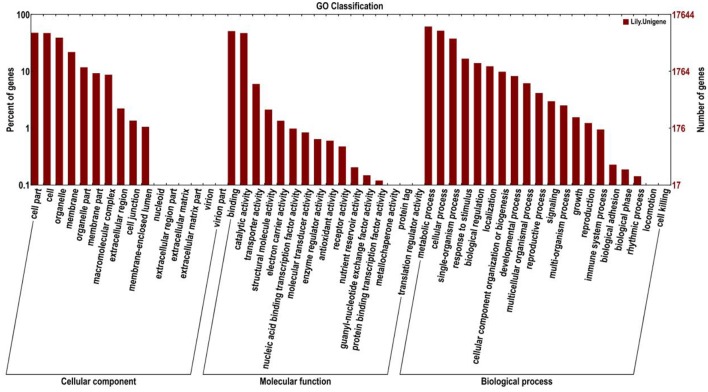
Histogram presentation of Gene Ontology (GO) classifications. Left y-axis indicates the percentage of unigenes in subcategories of each main category. Right y-axis indicates the number of unigenes in each subcategory.